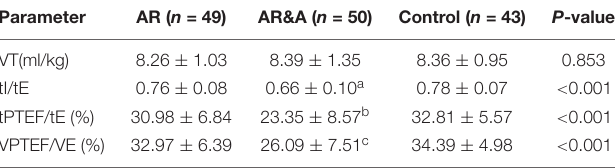
TABLE 2 | Comparison of tidal breathing parameters among three